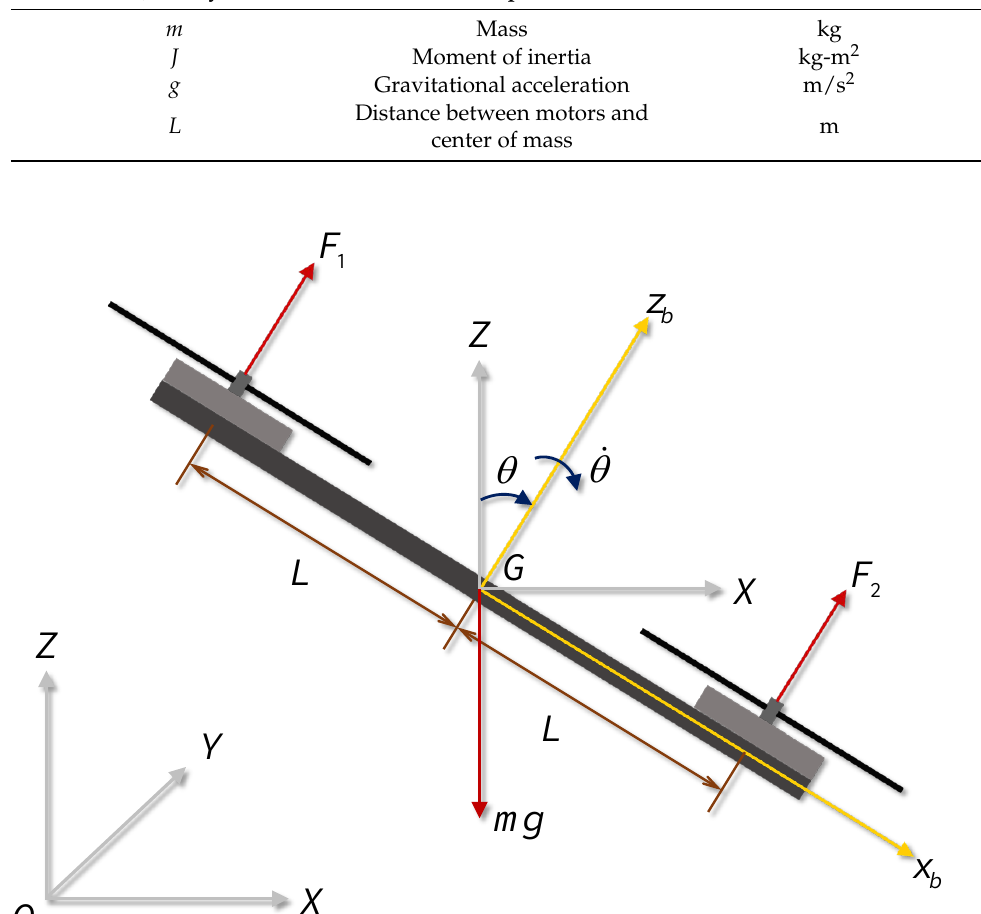
Figure 1. The dynamic configuration of the 3-DoF quadrotor